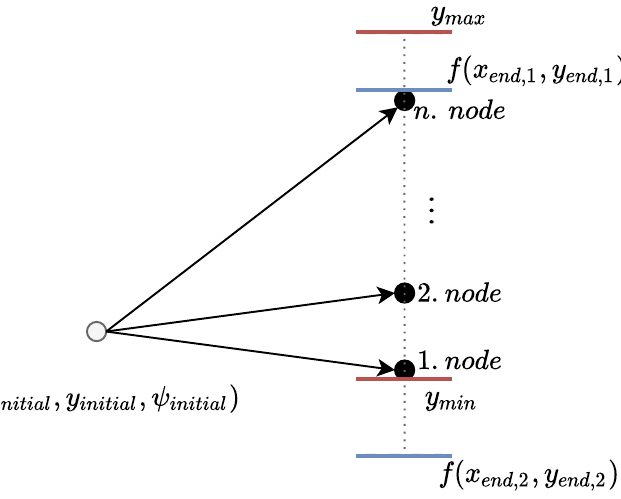
Figure 2. Limitations during the graph generation.